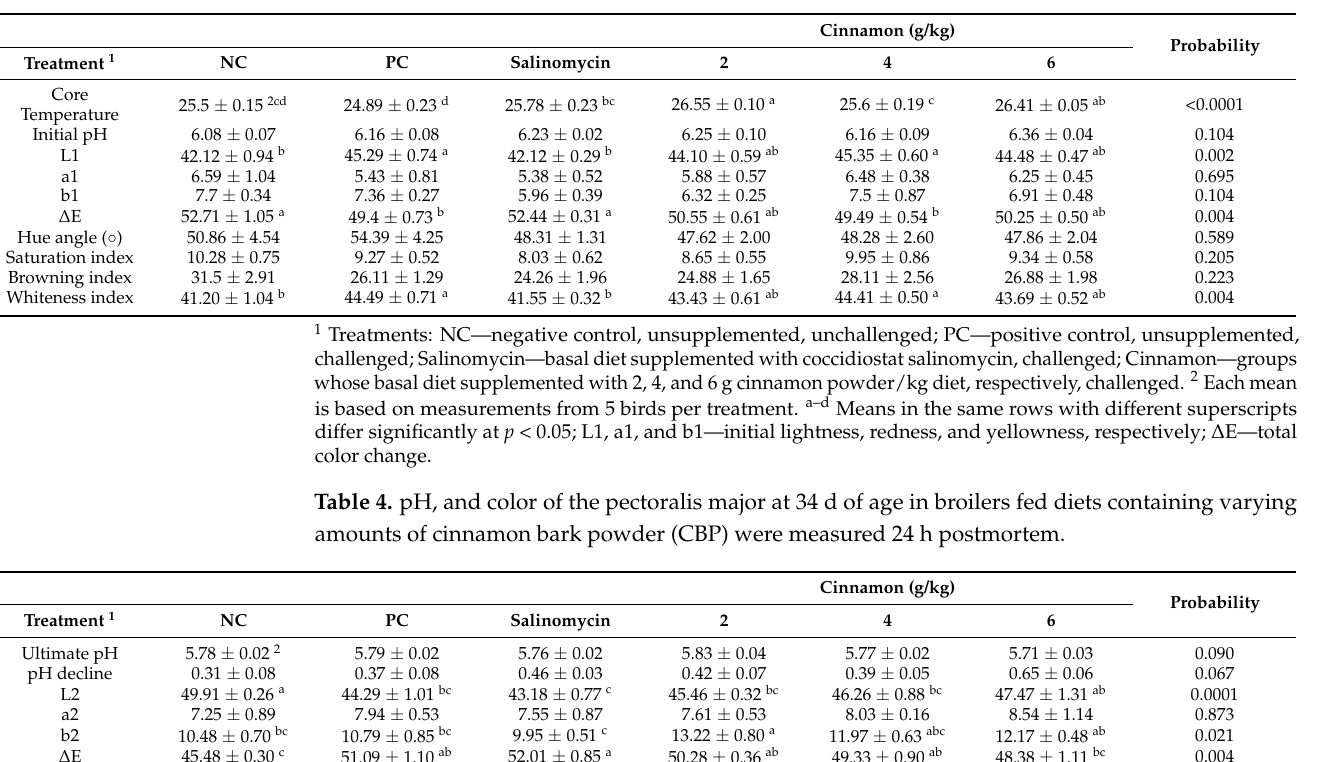
Table 3. Core temperature, pH, and color of the pectoralis major at 34 d of age in broilers fed diets containing varying amounts of cinnamon bark powder (CBP) were measured 1 h postmortem.